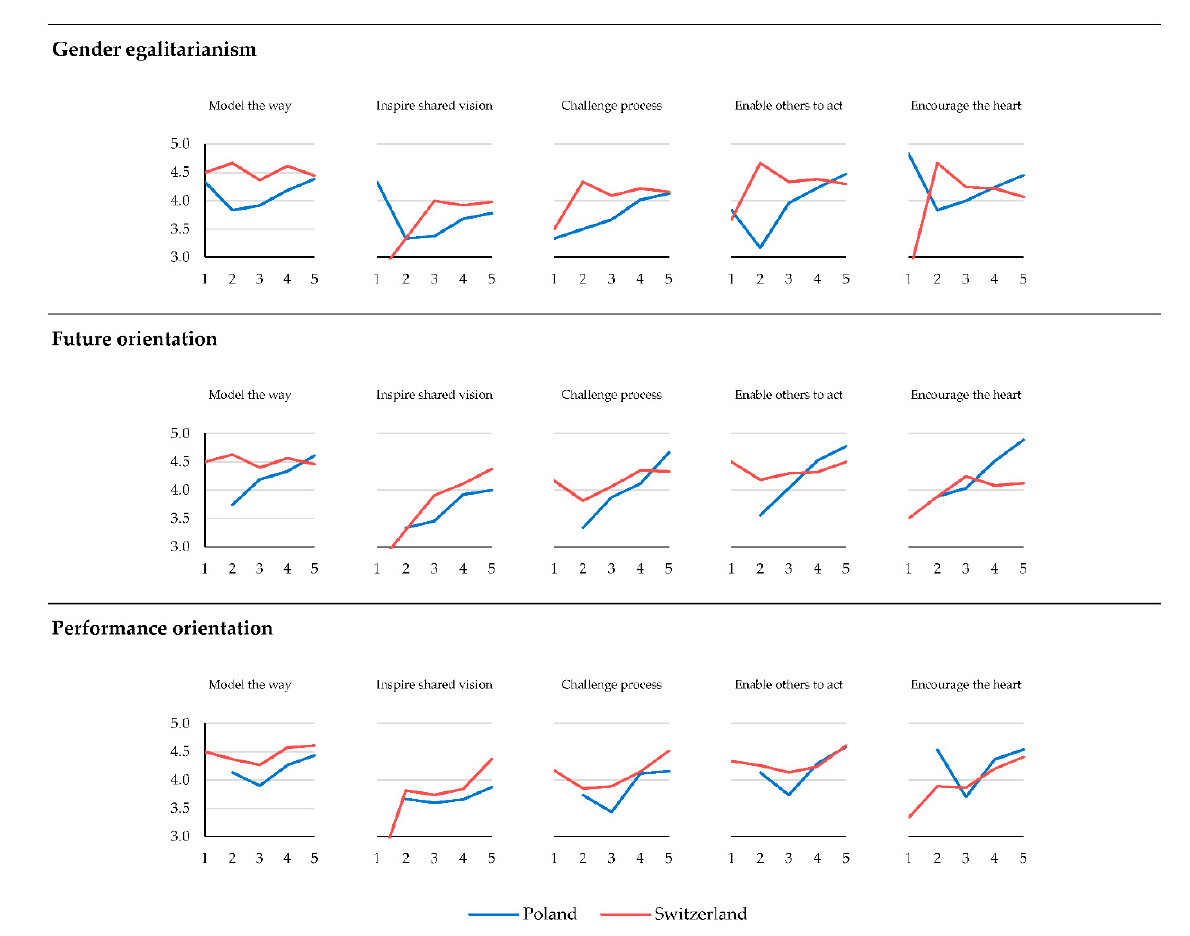
Figure 4. Importance of leadership factor by score on cultural dimension. Table 8. Impact of cultural dimensions on importance (high scores vs. low